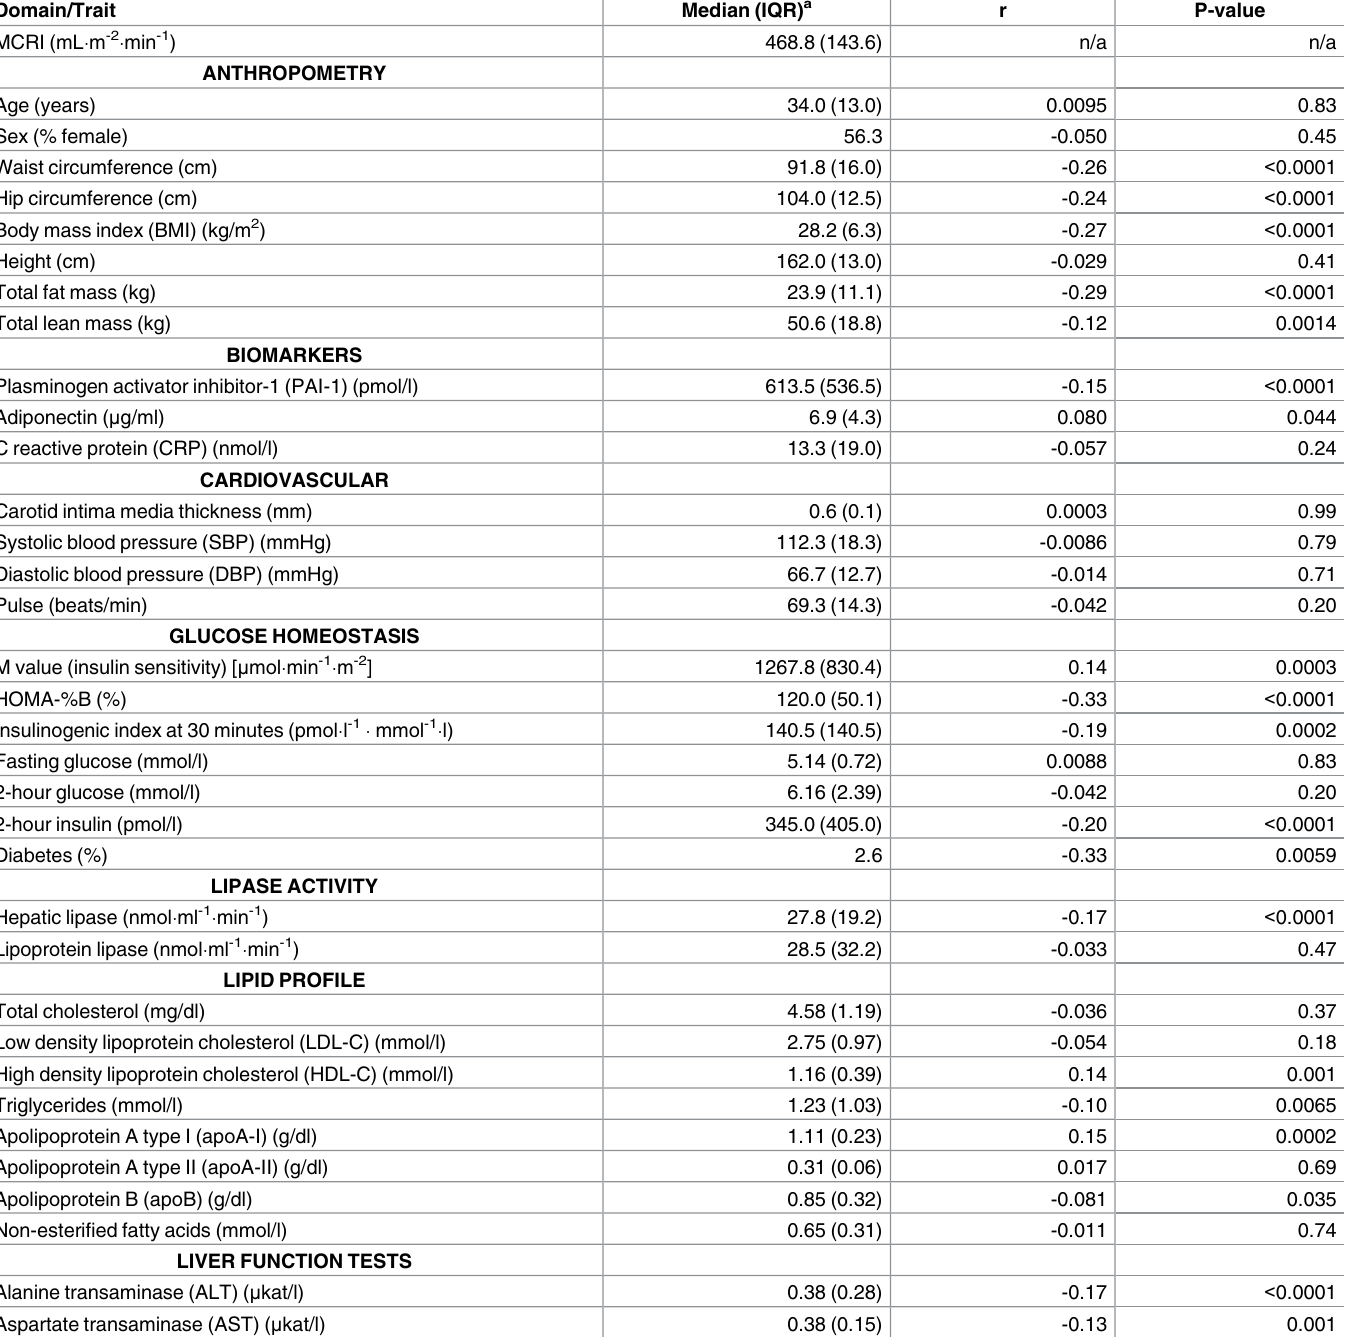
Table 1. Clinical characteristics and univariate analyses of all traits.